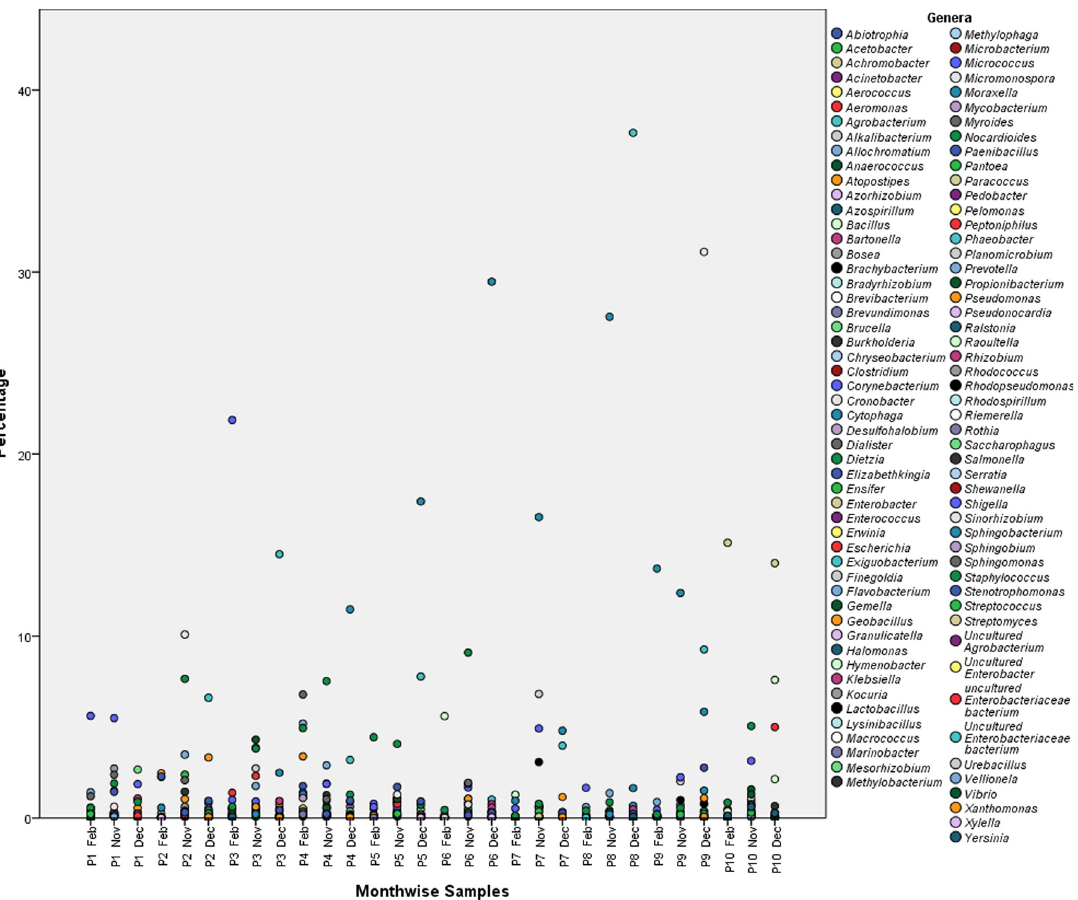
Fig 11. Distribution of all the genera in a cohort of ten individuals at three different time points. The percentage (RA) are plotted on the Y-axis for the corresponding subject plotted on